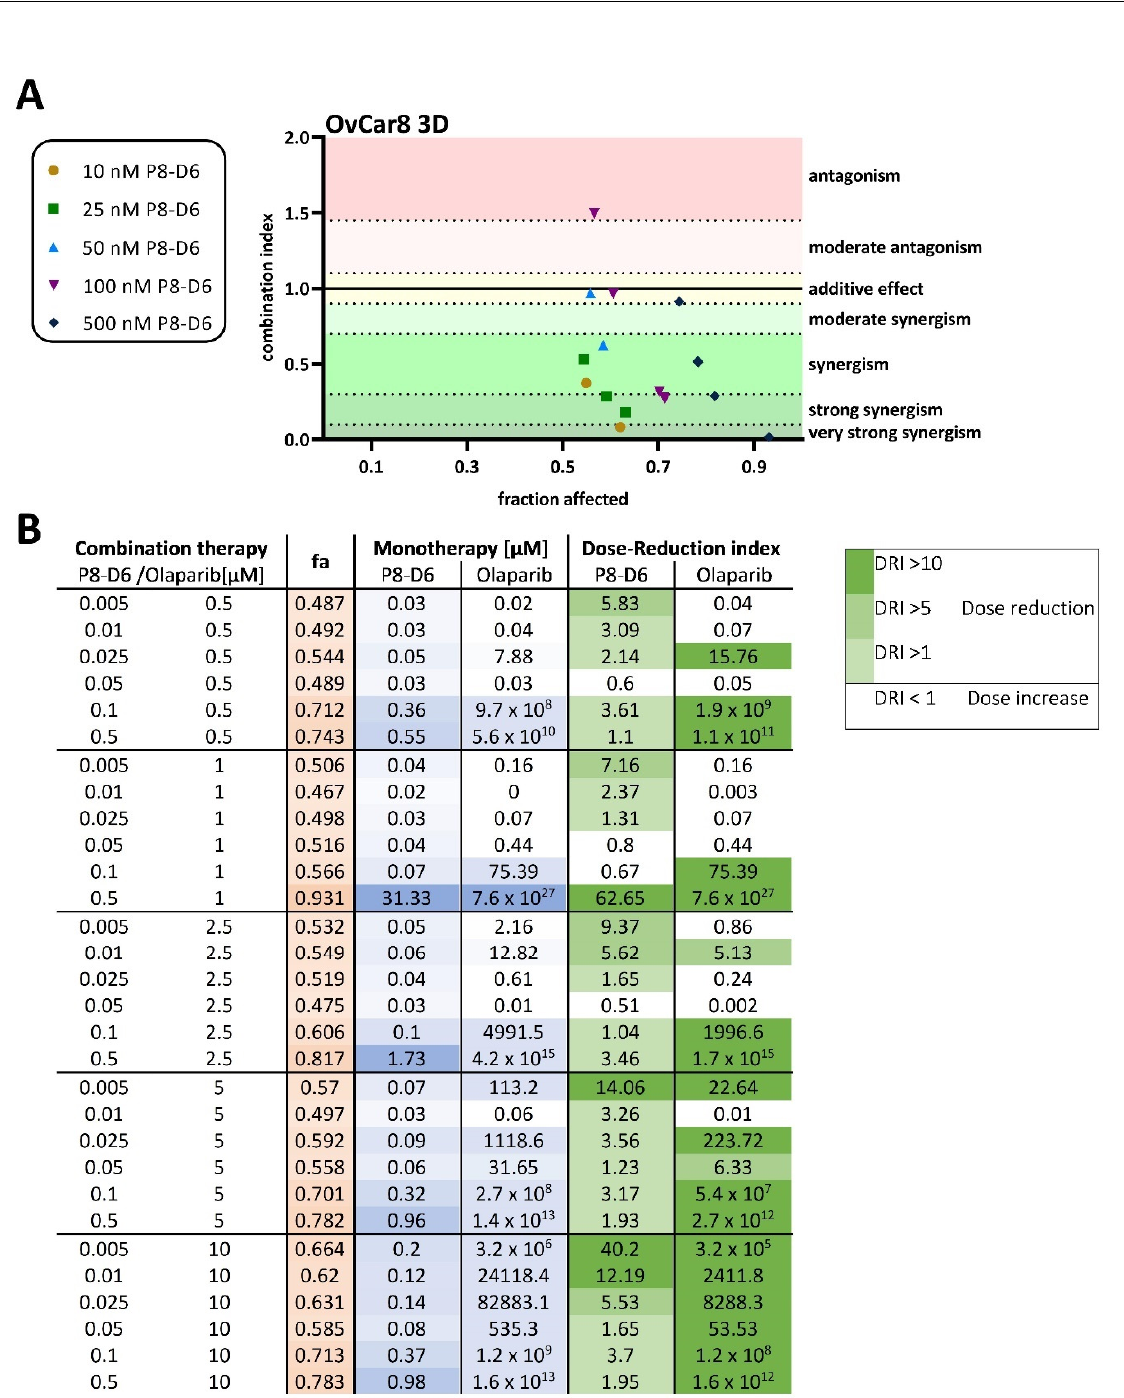
activity were measured. ( B ) The IC 50 value of each olaparib concentration was calculated using the viability data. ( C ) The apoptosis is represented as relative caspase activity. Data are means + SEM